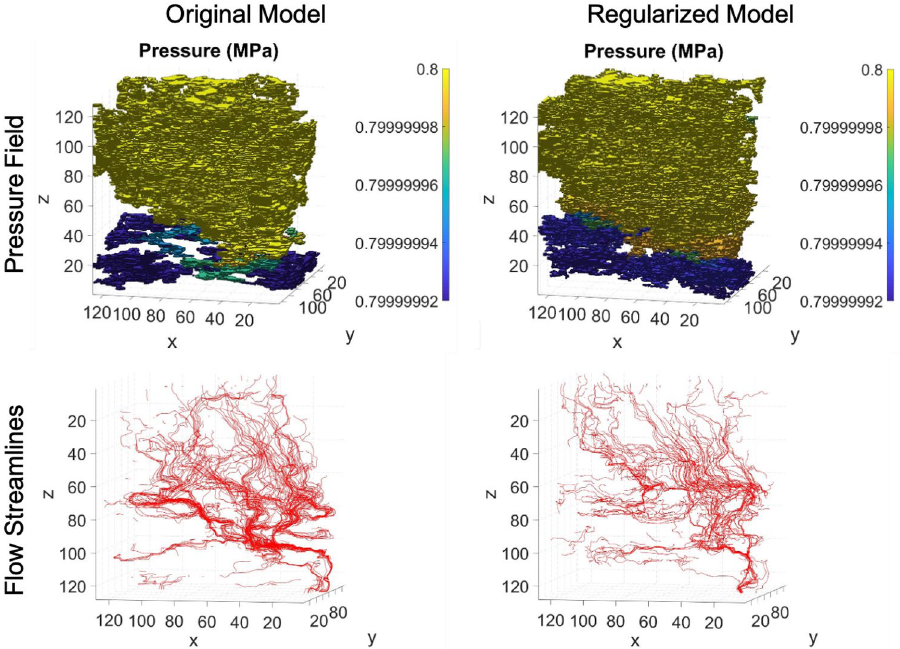
Figure 6. Comparison of pressure fields and flow streamlines in the original volume and in post-processed volumes created with a regularized model. The different models produce substantially different results in flow paths and pressure fields. The original model has more active cells in the simulation domain and therefore produces more flow streamlines. The streamlines for the regularized model, however, have greater continuity in the z direction. Software: Powerpoint www. micro soft. com, MATLAB www. mathw orks.